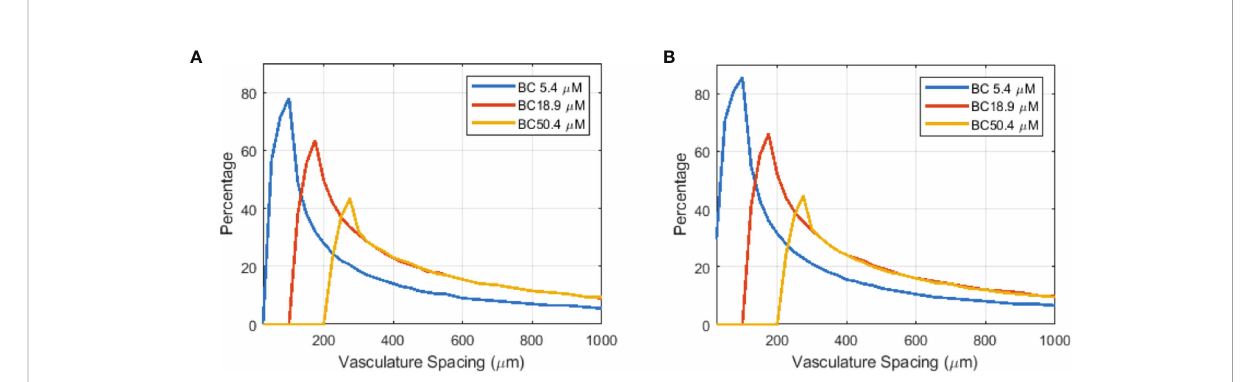
FIGURE 7 Flash effective-dose-modifying factor relates to vasculature spacing, oxygen BCs, and FLASH dose rates. Percentage of the region with FEDMF ≥ 1.20 is plotted against the vasculature spacing for different BCs (5.4, 18.9, and 50.4 m M) for two different proton FLASH dose rates: (A) 125 Gy/s and (B) 285